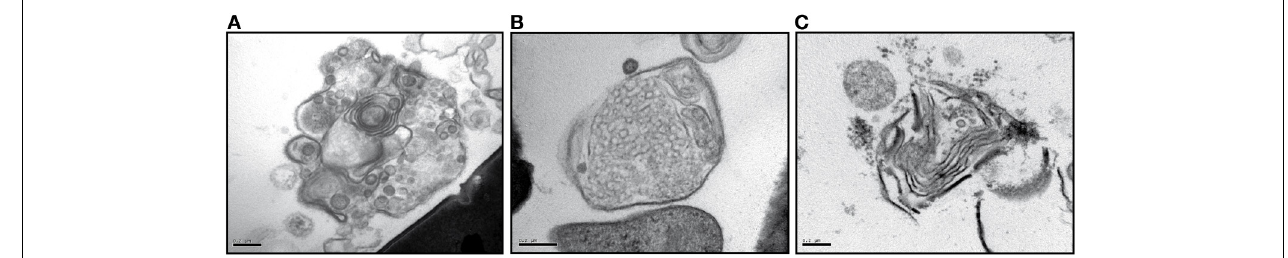
FIGURE 2 | MLBs secreted by D. discoideum cells grown on Gram-positive bacteria. Transmission electron microscopic images of MLBs secreted by D. discoideum DH1-10 cells (Cornillon et al., 2000)